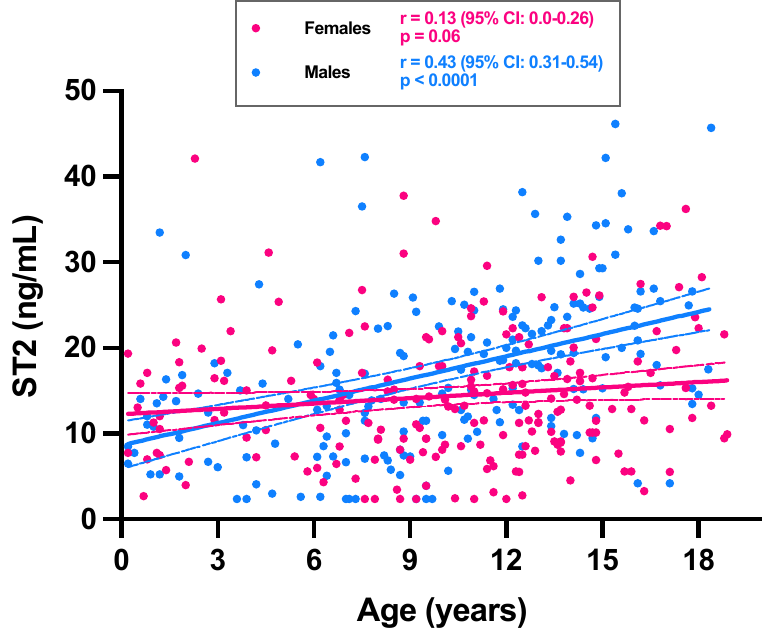
Figure 1. ST2 concentrations among 412 pediatric subjects as a function of age and sex. Trend for ST2 as a function of age is expressed for females (pink dots) and males (blue dots). Simple linear regressions are represented with continuous lines. Dotted lines correspond to the 95% CI of the linear regression.